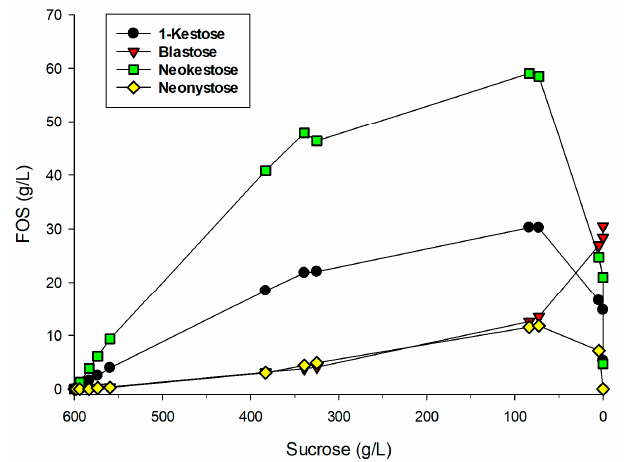
Figure 6. Kinetics of FOS formation with entrapped pXd-INV in PVA. Reaction conditions: 600 g/L sucrose, 100 mM sodium acetate buffer (pH 5.0), 30 °C.